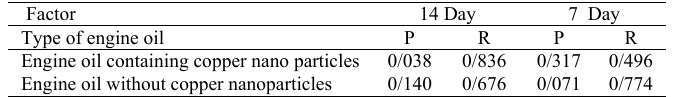
Table 1. Correlation between lethality and increasing concentration in soil test on days 7 and 14